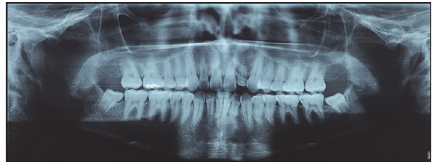
Figure 1: Panoramic